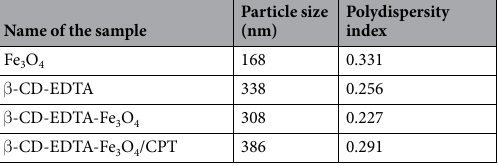
Table 1. Particle size and polydispersity index analyses of Fe 3 O 4 , β -CD-EDTA, β -CD-EDTA-Fe 3 O 4, and β -CD- EDTA-Fe